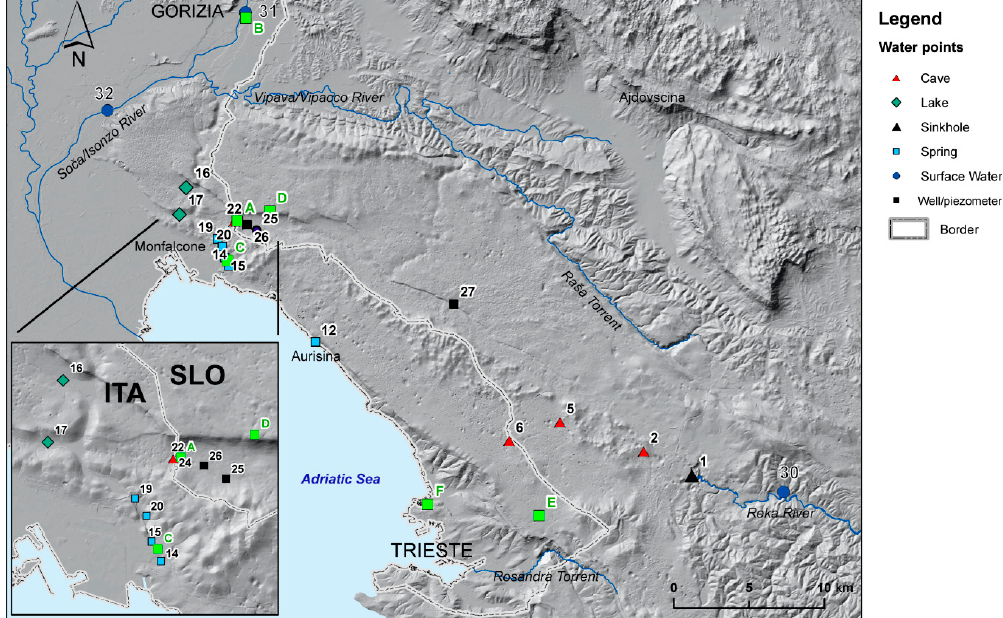
Figure 2. Sampling points within the study area. In the box (left below) the zoom is highlighting the spring area at San Giovanni di Duino. Green squares represent the pluviometers: A—Klariˇci; B—Gorizia; C—Randaccio; D—Sela na Krasu; E—Brestovizza; F—Filzi-Trieste. The other points are: Škocjanske jame (1); Kaˇcna jama (2); Jama v Kanjaducah (5); Abisso di Trebiciano (6); Aurisina spring (12); Timavo Spring (14); Sardos Spring (15); Doberd ò Lake (16); Pietrarossa Lake (17); Moschenizze North Spring (19); Moschenizze South Spring (20); B4—Klariˇci pumping station (22); Štorje piezometer (23); Cavernetta di Comarie (24); B2 piezometer (25); B9 piezometer (26); P1 piezometer (27); Reka River (30); Soˇca/Isonzo River Is1 (31); Soˇca/Isonzo River Is2 (32). Temperature (T), pH, Electrical Conductivity (EC), major elements (anions and cations) and silica (SiO 2 ) (Table 1) as well as the environmental isotopes ( δ 18 O, δ 2 H, 87 Sr/ 86 Sr) were determined (Table